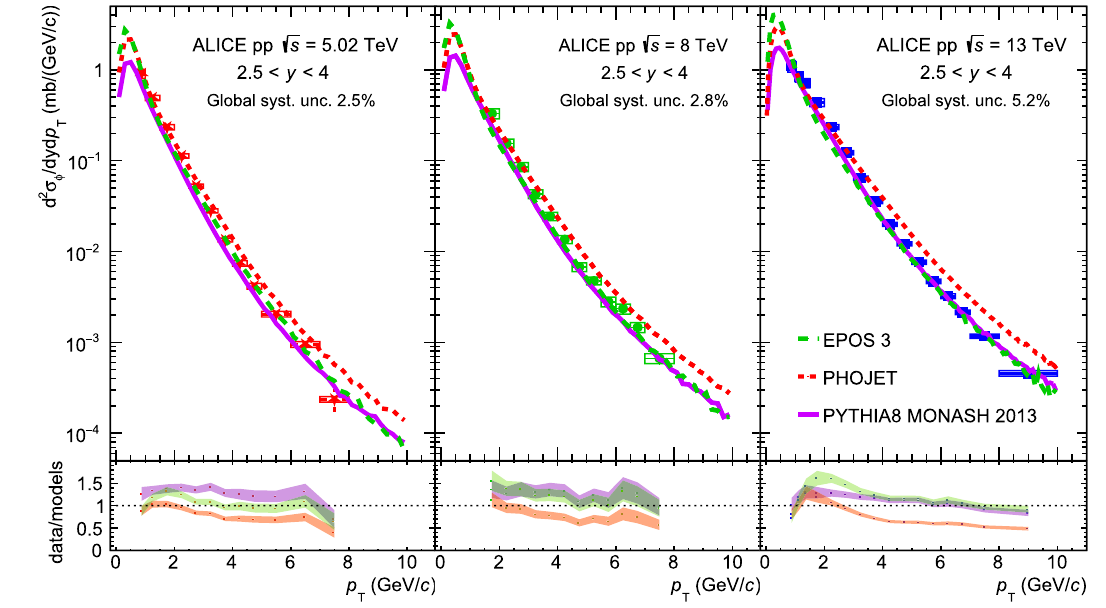
Fig. 4 Top: differential φ meson production cross section d 2 σ/ d y d p T of PYTHIA 8.1 [1]. The boxes represent the systematic uncertainties, √ √ s = 5 . 02 TeV (left), s = 8 TeV (center) as a function of p T at the error bars the statistical uncertainties. Bottom: ratio between the √ s = 13 TeV (right) in the rapidity interval 2 . 5 < y < 4, com- and measured cross section and the pared with EPOS 3 [8–10], PHOJET [6,7] and the Monash 2013 tune